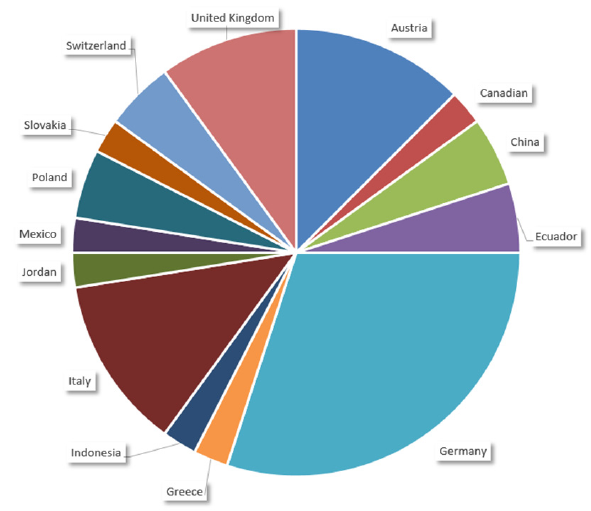
Figure 2. Breakdown of participants’ country of origin